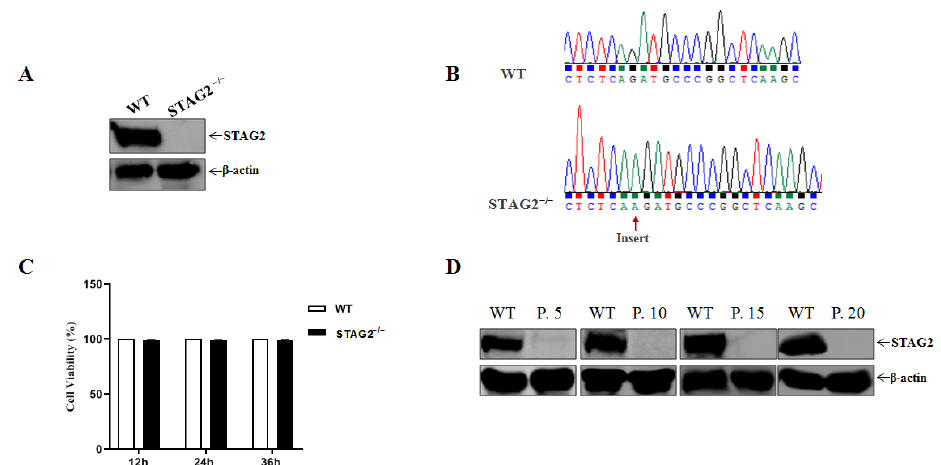
Figure 1. Establishment of STAG2-depleted IPEC-J2 cells line. ( A ) Western blot analysis for STAG2 expression in IPEC-J2 cell line; ( B ) Gene sequence alignment revealed that were heterozygous for STAG2 knockout alleles generated using CRISPR-Cas9 gene editing; ( C ) Cell viability was determined using CCK-8 detection; ( D ) Western blot analysis for STAG2 expression of WT IPEC-J2, STAG2 − / − IPEC-J2 passage 5 (P. 5), passage 10 (P. 10), passage 15 (P. 15) and passage 20 (P. 20).